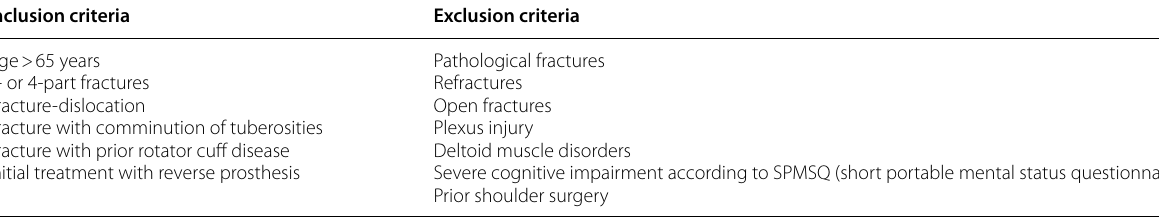
Table 1 Inclusion and exclusion criteria Inclusion criteria Exclusion criteria